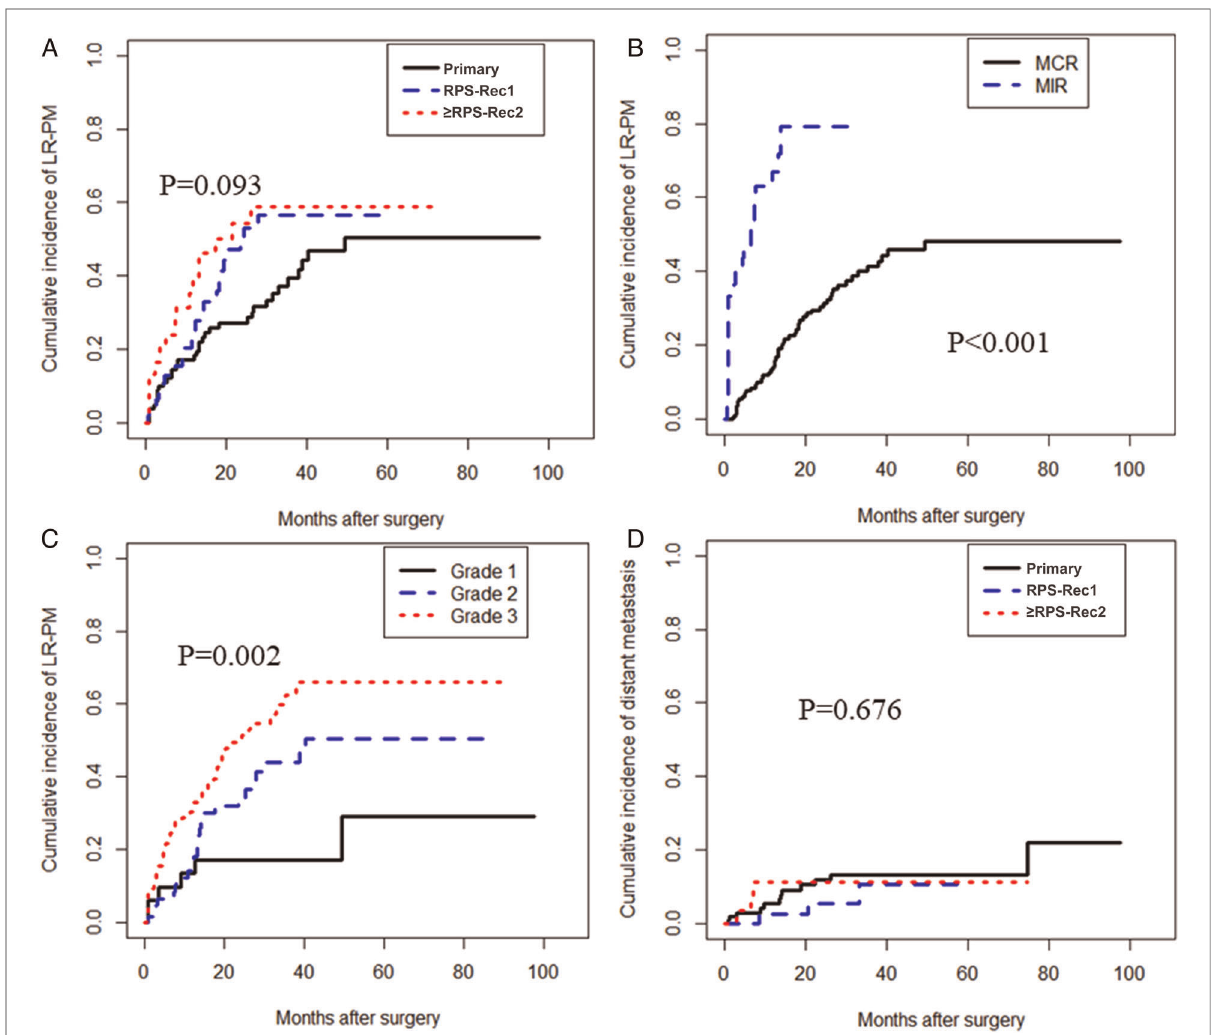
FIGURE 3 Local recurrence and/or peritoneal metastasis and distant metastasis. ( A ) The cumulative incidence of LR-PM in primary, RPS-Rec1, and ≥ RPS-Rec2 patients (primary vs. RPS-Rec1, P =0.164; primary vs. ≥ RPS-Rec2, P =0.044). ( B ) The cumulative incidence of LR-PM in MCR and MIR patients ( P < 0.001). ( C ) The cumulative incidence of LR-PM in different grade RPS patients (grade 1 vs. grade 2, P =0.066; grade 1 vs. grade 3, P =0.001). ( D ) The cumulative incidence of distant metastasis in primary, RPS-Rec1, and ≥ RPS-Rec2 patients (primary vs. RPS-Rec1, P =0.388; primary vs. ≥ RPS-Rec2, P =0.913). LR-PM, local recurrence and/or peritoneal metastasis; MCR, macroscopically complete resection; MIR, macroscopically incomplete